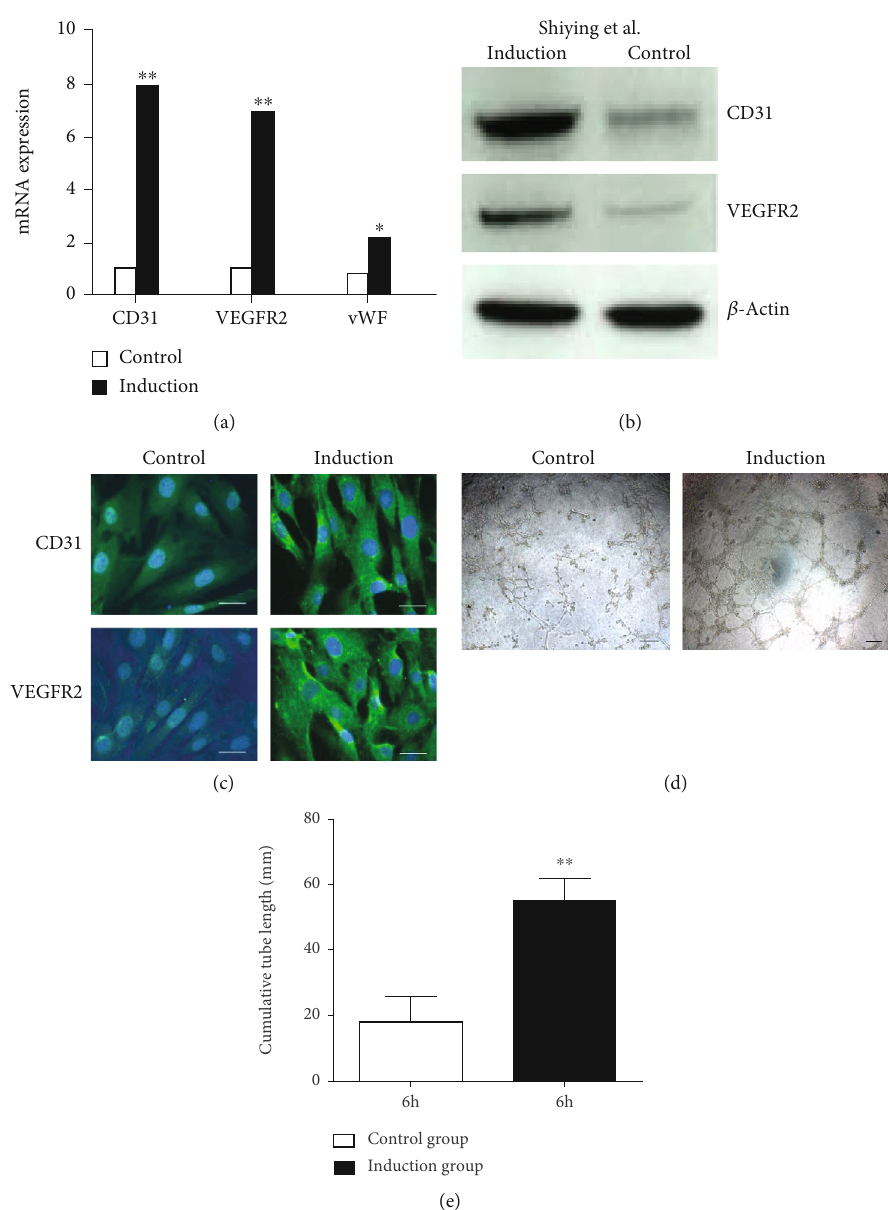
Figure 7: CD34 + CD117 + HGSV-AdPCs di ff erentiated into endothelial cells in vitro . CD34 + CD117 + HGSV-AdPCs were isolated with FACS and cultured in the presence of VEGF for 7 days. (a) The mRNA expression of CD31, VEGFR2, and vWF. (b) The result of Western blotting of CD31 and VEGFR2 proteins in the induction and control groups. (c) The di ff erentiation result of immuno fl uorescent staining with antibodies CD31 and VEGFR2 in control and induction groups. (d) The tube formation observed under inverse microscope at 6 hours culture in control and induction groups. (e) The di ff erence of tube formation at 6 hours culture between control and induction groups. Scale bars: 10 μ m (c); 200 μ m (d). Magni fi cation: 200x (a, cells in vitro . FACS was used to isolate CD34 + CD117 + (Figure 6(c)) and VEGFR2 (Suppl Figure IIIC), suggesting that the CM-Dil-labeled cells in the thrombi di ff erentiated HGSV-AdPC from primary cultures, and the cells were sub- into endothelial cells. jected to endothelial cell di ff erentiation in the culture medium in the presence of VEGF. Using real-time PCR, we found that VEGF showed signi fi cant gene expression of CD34 + CD117 + HGSV-AdPC Di ff erentiated into endothelial cell markers (CD31, VEGFR2, and vWF) Endothelial Cells In Vitro. After the adventitial progenitor (Figure 7(a)). The induction of endothelial cell di ff erentiation cells cross the vein wall, they enter into thrombi and di ff eren- at protein level was con fi rmed by Western blotting tiate into endothelial cells in vivo , and so we attempted to (Figure 7(b)) and immuno fl uorescent staining (Figure 7(c)), explore the di ff erentiation of CD34 + CD117 + into endothelial